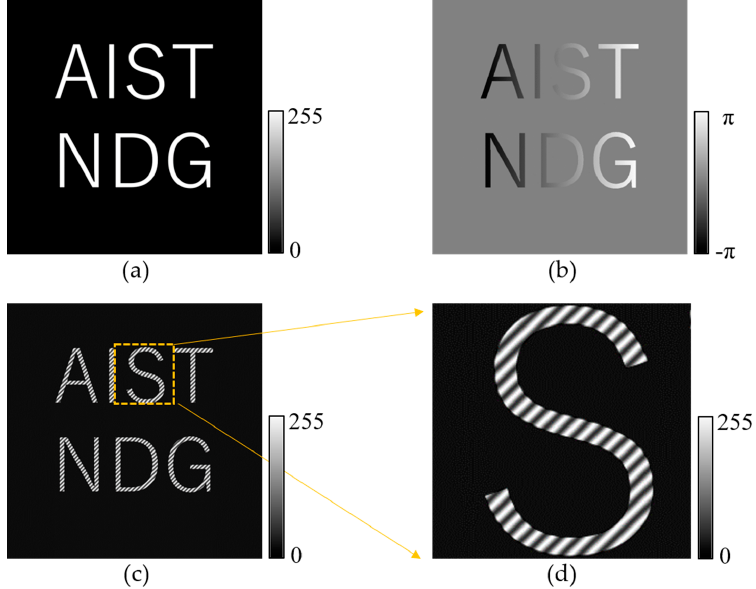
Figure 4. Simulated object and an example of the generated hologram. ( a , b ) Amplitude and phase distributions; ( c ) Example of the generated hologram; ( d ) Magnified image of the area indicated in ( c ).